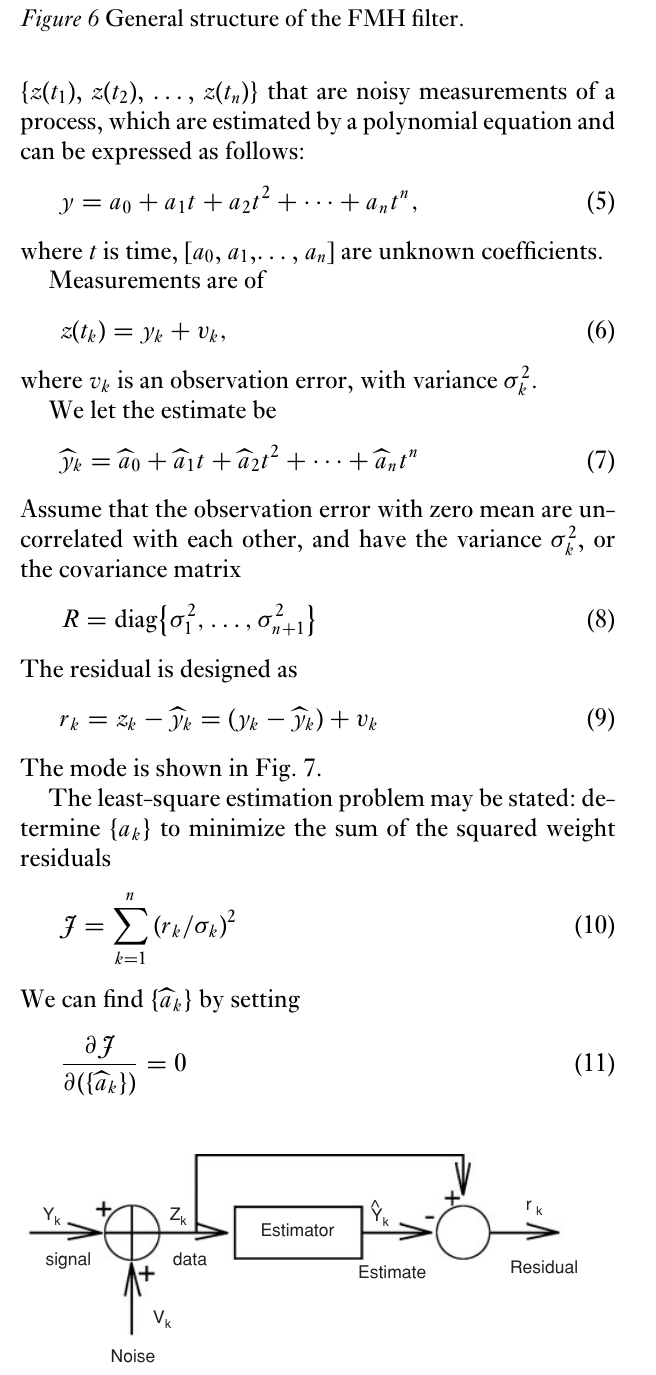
Figure 7 The block diagram of the estimator.